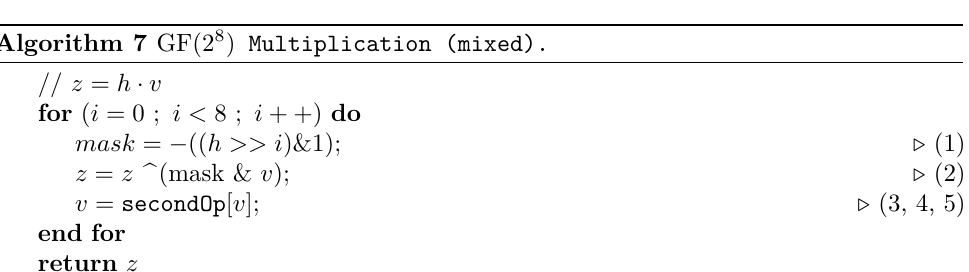
Algorithm 7 GF(2 8 ) Multiplication